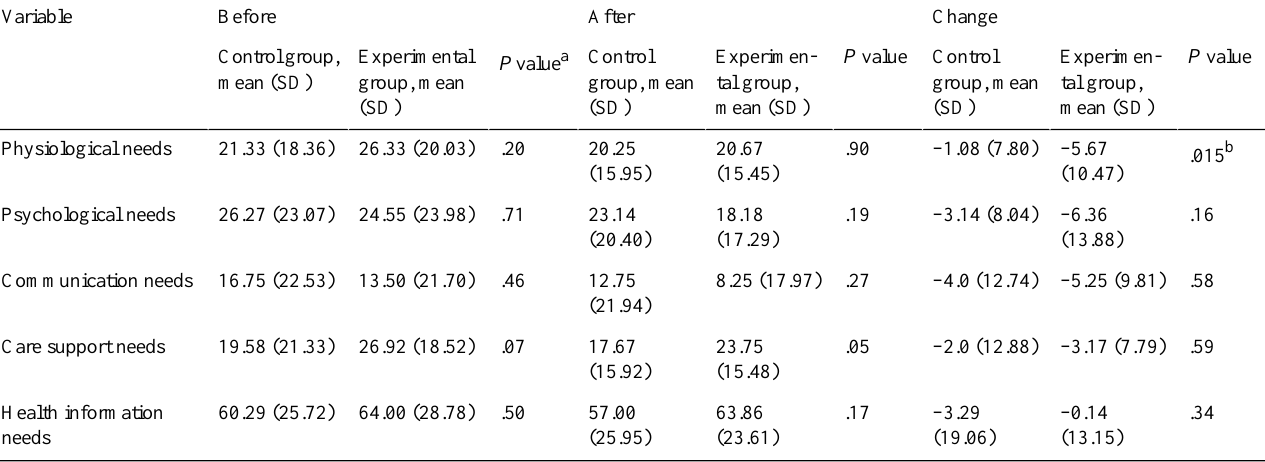
Table 3. Care needs of patients in the study (N=100) before and after the mHealth app intervention measured with the short-form Cancer Needs Questionnaire.